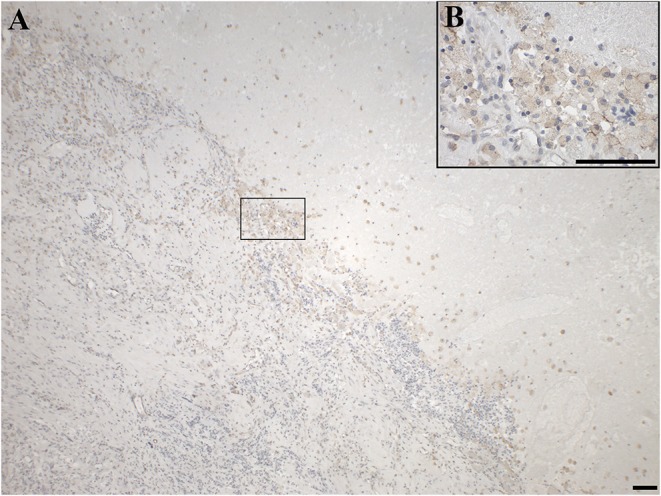
Immunohistochemical staining for GAL3-R of a gliosarcoma (WHO grade IV; case 25), showing positive GAMs at the junction of tumor tissue and necrotic tissue in (A) 4 × and (B) 40 × magnification. [scale bar: 100 μm].